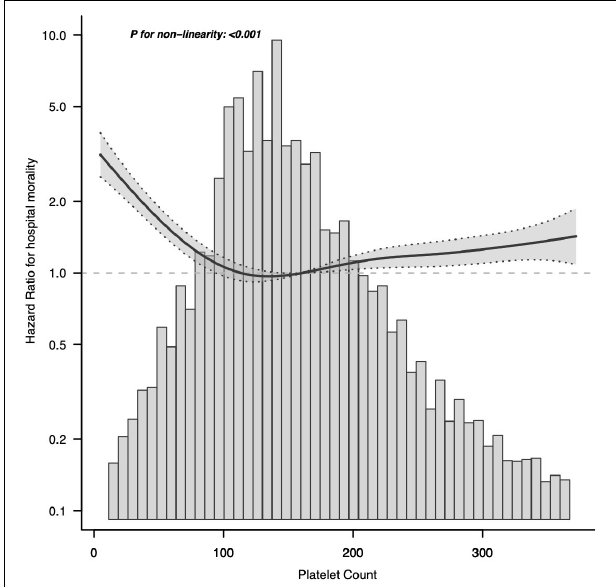
FIGURE 3 | Associations between platelet count concentrations with 28-day mortality among participants with sepsis in MIMIC-IV. HRs were adjusted for age, sex, ethnicity, BMI, CHF, COPD, liver, renal, diabetes, metastatic tumor, AIDS, Charlson, abdomen, bloodstream, respiratory tract, urinary tract, catheter, MV, RRT, SAPS II, length of ICU stay, length of hospital stay, hemoglobin, WBC, Cr, BUN, PT, INR, PTT, HR, SBP, DBP, and MAP. Both p linearity, 0.001. BMI, body mass index; CHF, congestive heart failure; COPD, chronic obstructive pulmonary disease; SAPS II, Simplified Acute Physiology Score II; MV, mechanical ventilation; RRT, renal replacement therapy; WBC, white blood cell count; Cr, creatinine; BUN, blood urea nitrogen; PT, prothrombin time; INR, international normalized ratio; PTT, partial thromboplastin time; HR, heart rate; SBP, systolic blood pressure; DBP, diastolic blood pressure; MAP, mean arterial